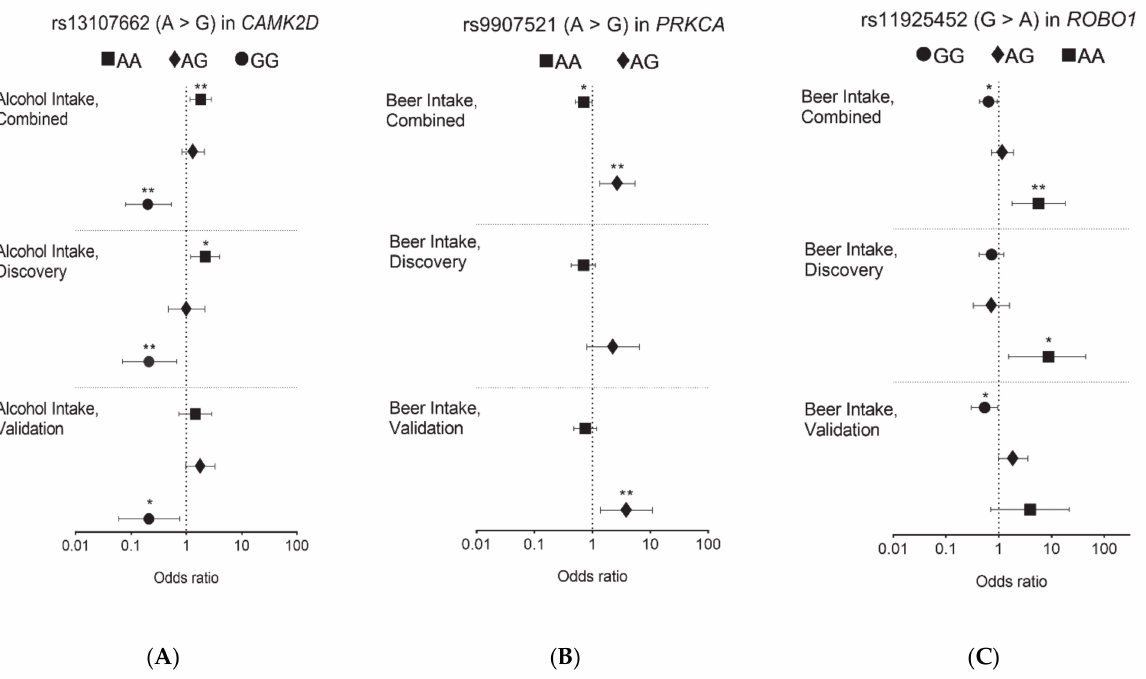
Figure 2. Alcohol intake impact on prostate cancer aggressiveness by the selected genotype profile. ( A ) Heavy alcohol intake impact by genotypes of rs13107662 in CAMK2D ; ( B ) heavy beer intake impact by genotypes of rs9907521 in PRKCA ; ( C ) heavy beer intake impact by genotypes of rs11925452 in ROBO1. Note: *: p < 0.05, **: p < 0.01; Logistic models regression adjusted for study site, the six principal components, and smoking status. For a sample size <100 (rs13107662 GG for the discovery and validation set, rs11925452 AA for all sets, and rs9907521GG for all sets), unadjusted results were reported. The order of the genotypes was based on homozygous major, heterozygous, and homozygous minor